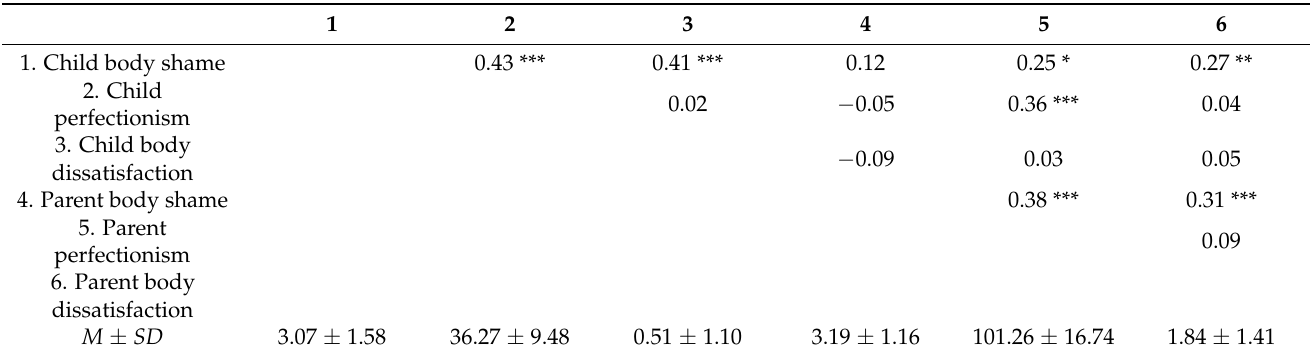
Table 2. Descriptive statistics and correlations of parent-child dyads in